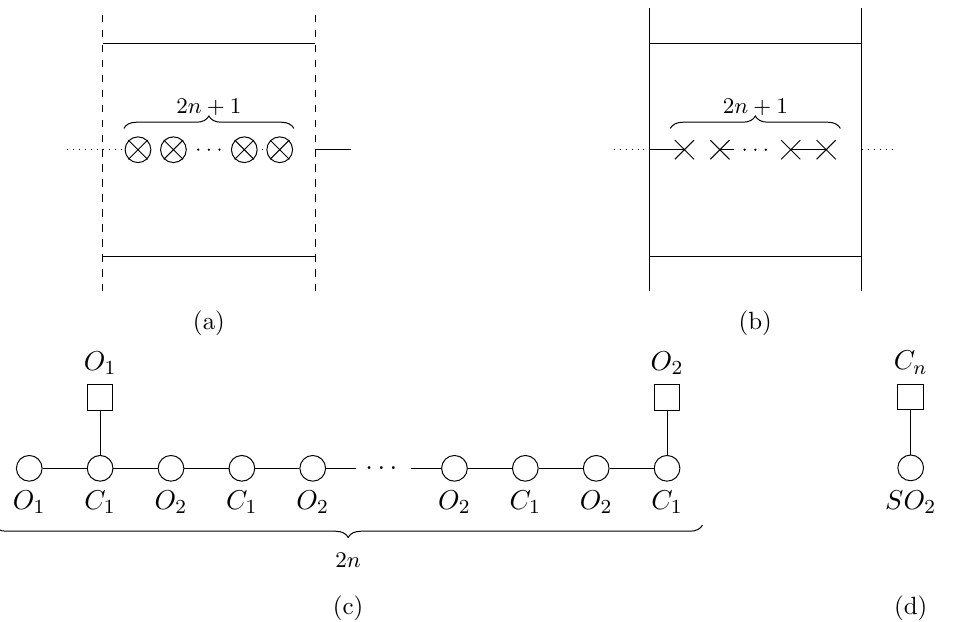
Figure 56. A 2 n (cid:0) 1 subregular singularity. (a) Brane subsystem that represents the moduli space generated by a single D3-brane in the leftmost interval of (cid:12)gure 55. In here, the rightmost g O 3 (cid:0) contributes as half a (cid:13)avor attached to the rightmost C 1 gauge node. (b) After S-duality the moduli space generated by this single D3-brane as a Coulomb branch. (c) Quiver corresponding to brane system (a), its Higgs branch is M H = A 2 n (cid:0) 1 . (d) Quiver corresponding to brane system (b), its Coulomb branch is M C = A 2 n (cid:0) 1